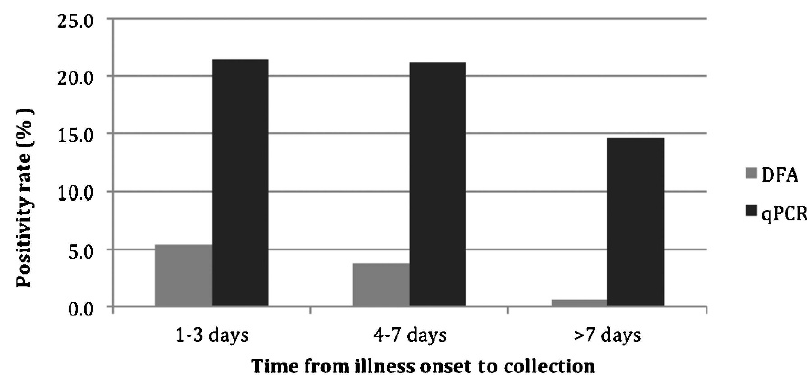
Figure 1 - Influenza positivity rate according to the time from illness onset to specimen collection.